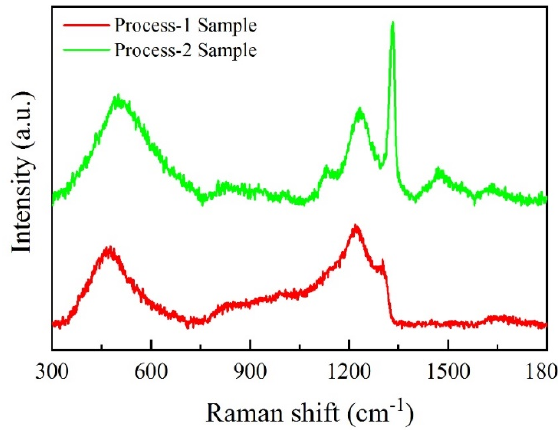
Figure 7. Raman spectra of the BDD coatings prepared by two processes. 245